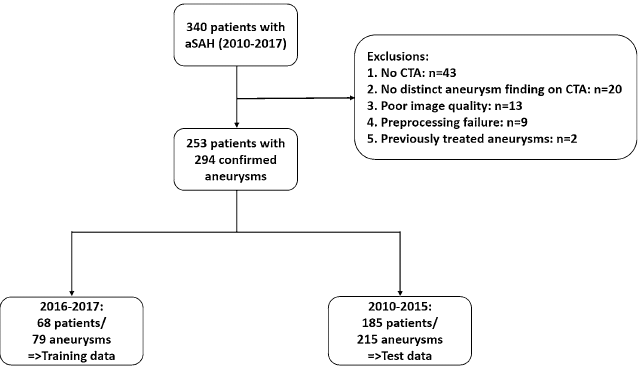
Figure 1. Flow chart for patient selection and inclusion scheme. aSAH = aneurysmal subarachnoid hemorrhage, CTA =